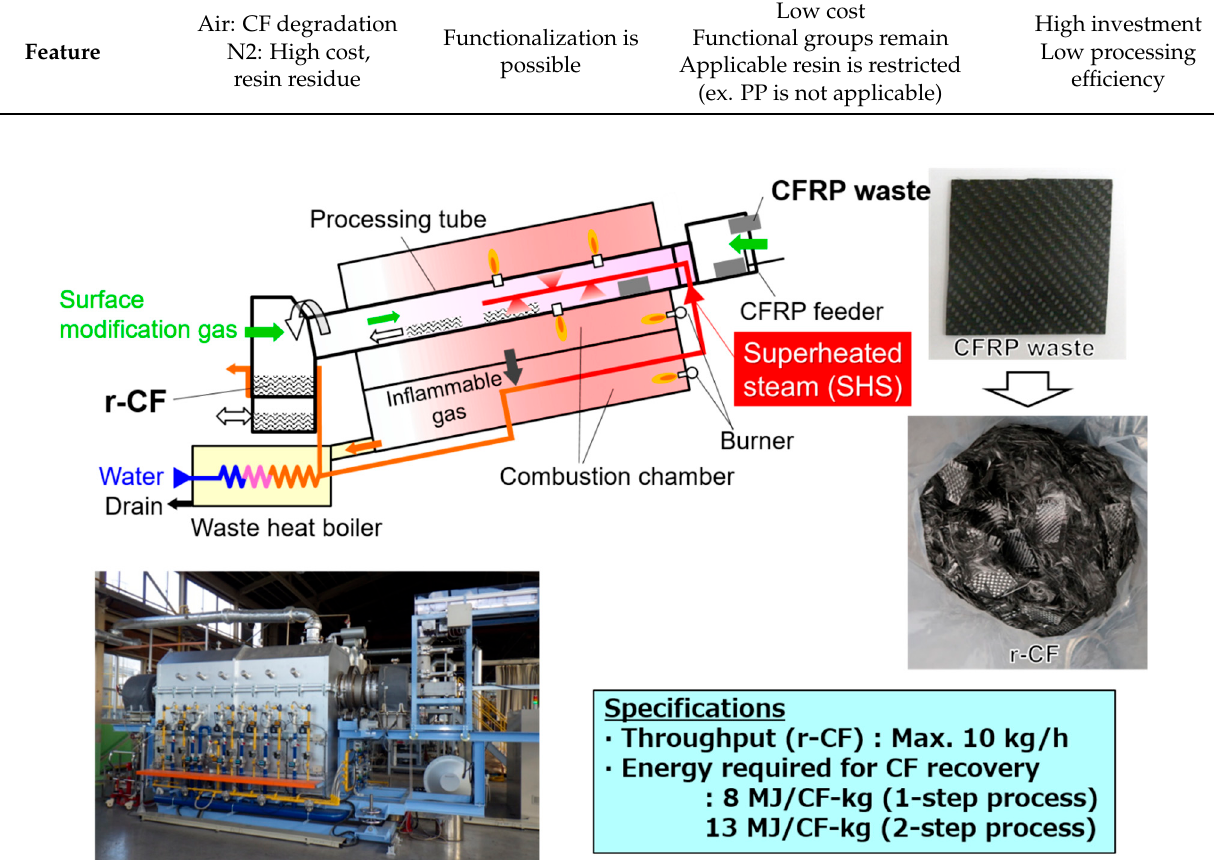
Figure 17. Superheated steam treatment process for recycling carbon fiber from CFRP parts.